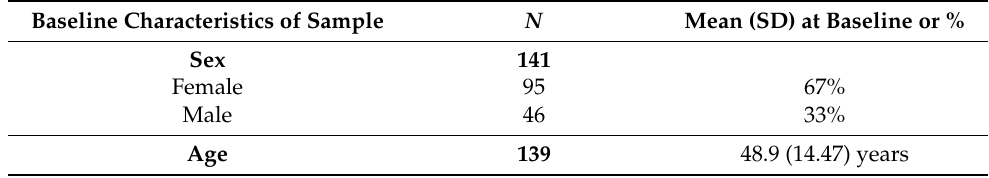
Table 1. Demographic, anthropometric, and readiness to change characteristics of sample at baseline. Baseline Characteristics of